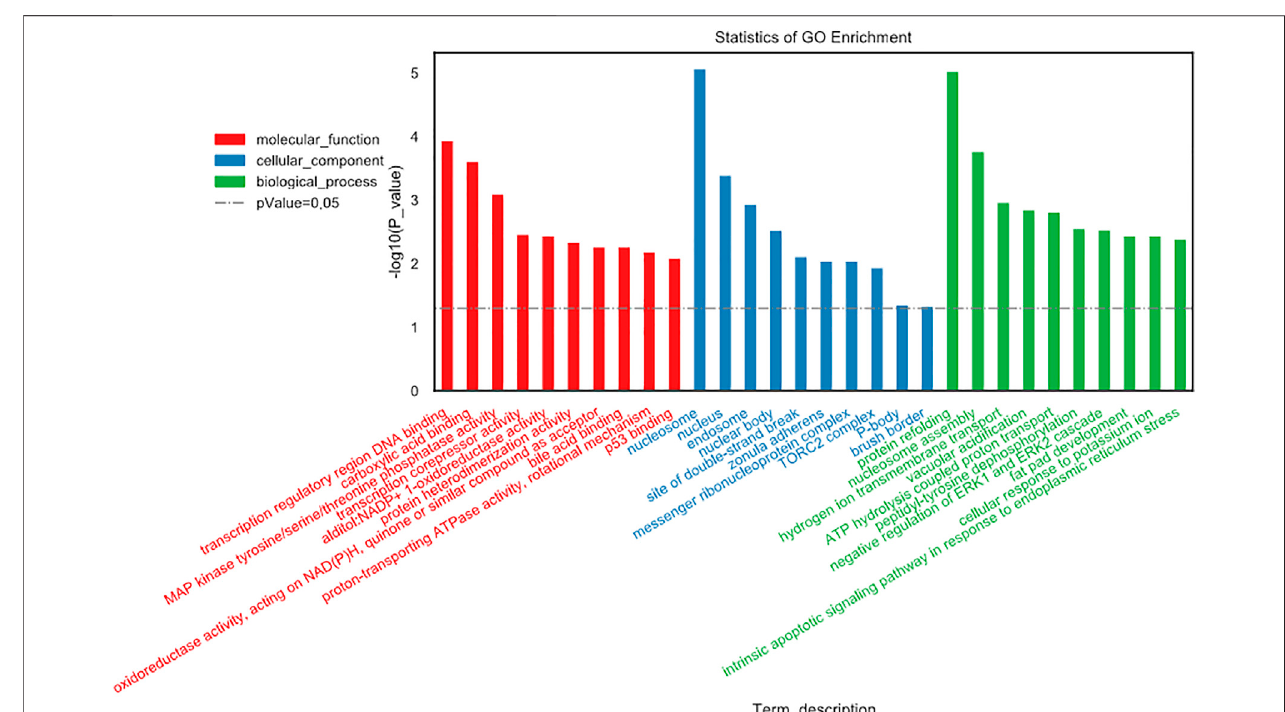
FIGURE 4 | Gene Ontology (GO) gene functional classi fi cation.